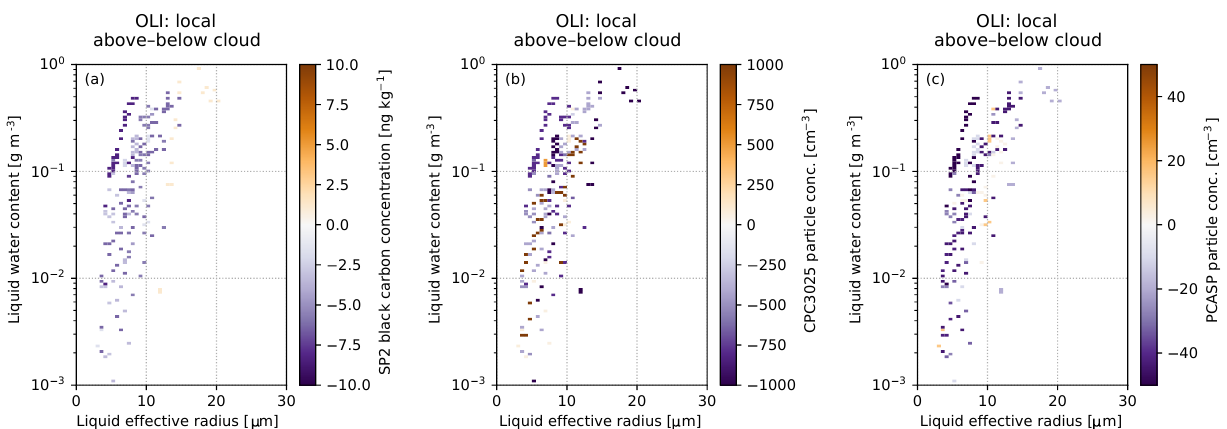
Figure 13. As Figs. 8, 10, and 11 for OLI, but showing the difference of rBC (a) , CN (b) , and PCASP concentration (c) between observations above and below the clouds classified as locally affected.